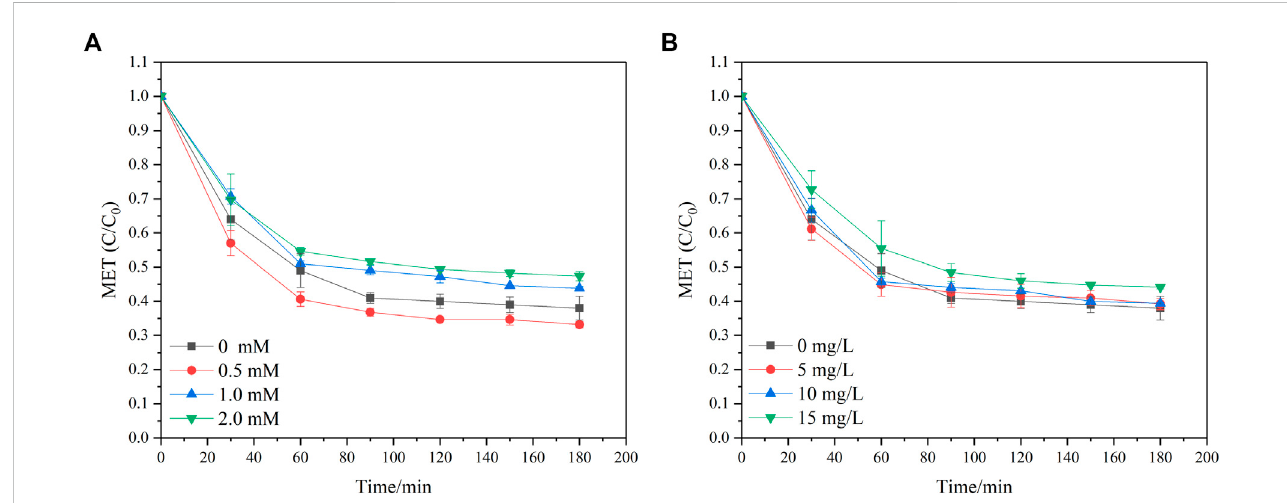
FIGURE 4 MET degradation with co-presence of (A) HCO 3 − and (B) FA. Experimental conditions: [MET] 0 = 10 mg/L, [SO 3 2- ] 0 = 10 mM, UV intensity = 100% I 0 , and pH =